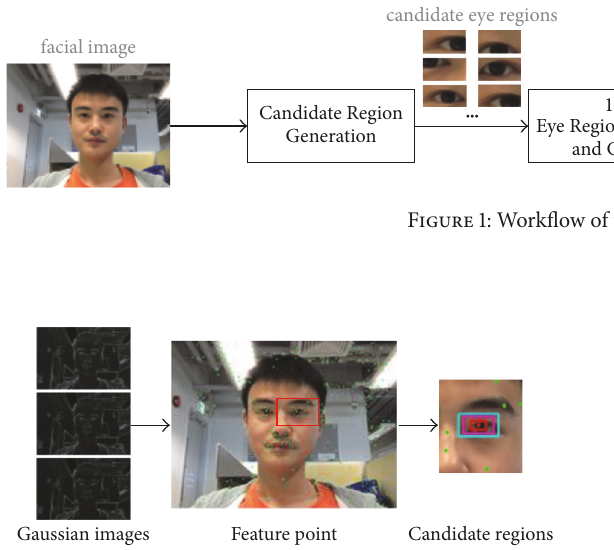
Figure 2: Top 𝑁 candidate feature points and the candidate eye regions.Red,magenta,andcyanboxesstandforcandidateregionsof different scales; the length of each candidate box is twice the